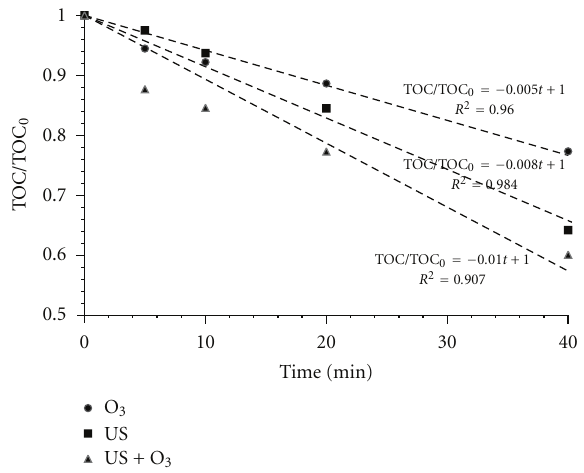
Figure 6: Comparative rates of diclofenac ( C 0 = 40mg/L) organic carbon decay in terms of TOC in 40min by sonolysis (20 kHz, 400W/L, NTC), ozonation (31g/h), and their simultaneous appli- cation (US+O 3 ).